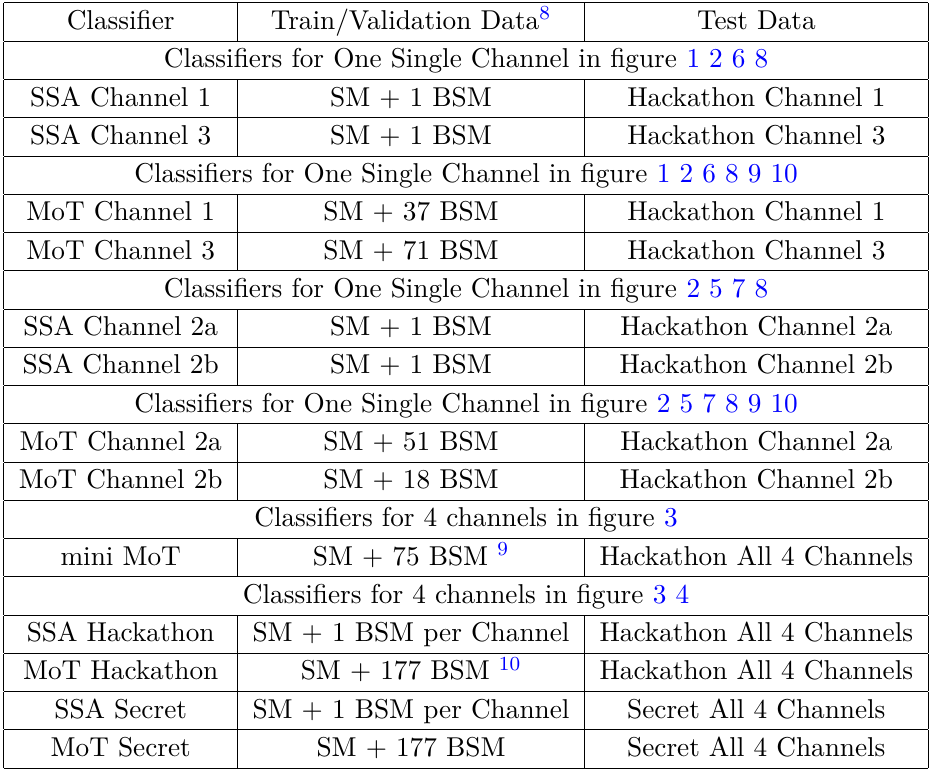
Table 1 . Summary of all classifiers used in the figures and comparisons, and the test and training data used to test and train these classifiers. SSA means that the classifier was trained with a single BSM signal for one analysis channel (single signal approach), MoT means that the classifier was trained with a mixture of many BSM models for one analysis channel (mixture of